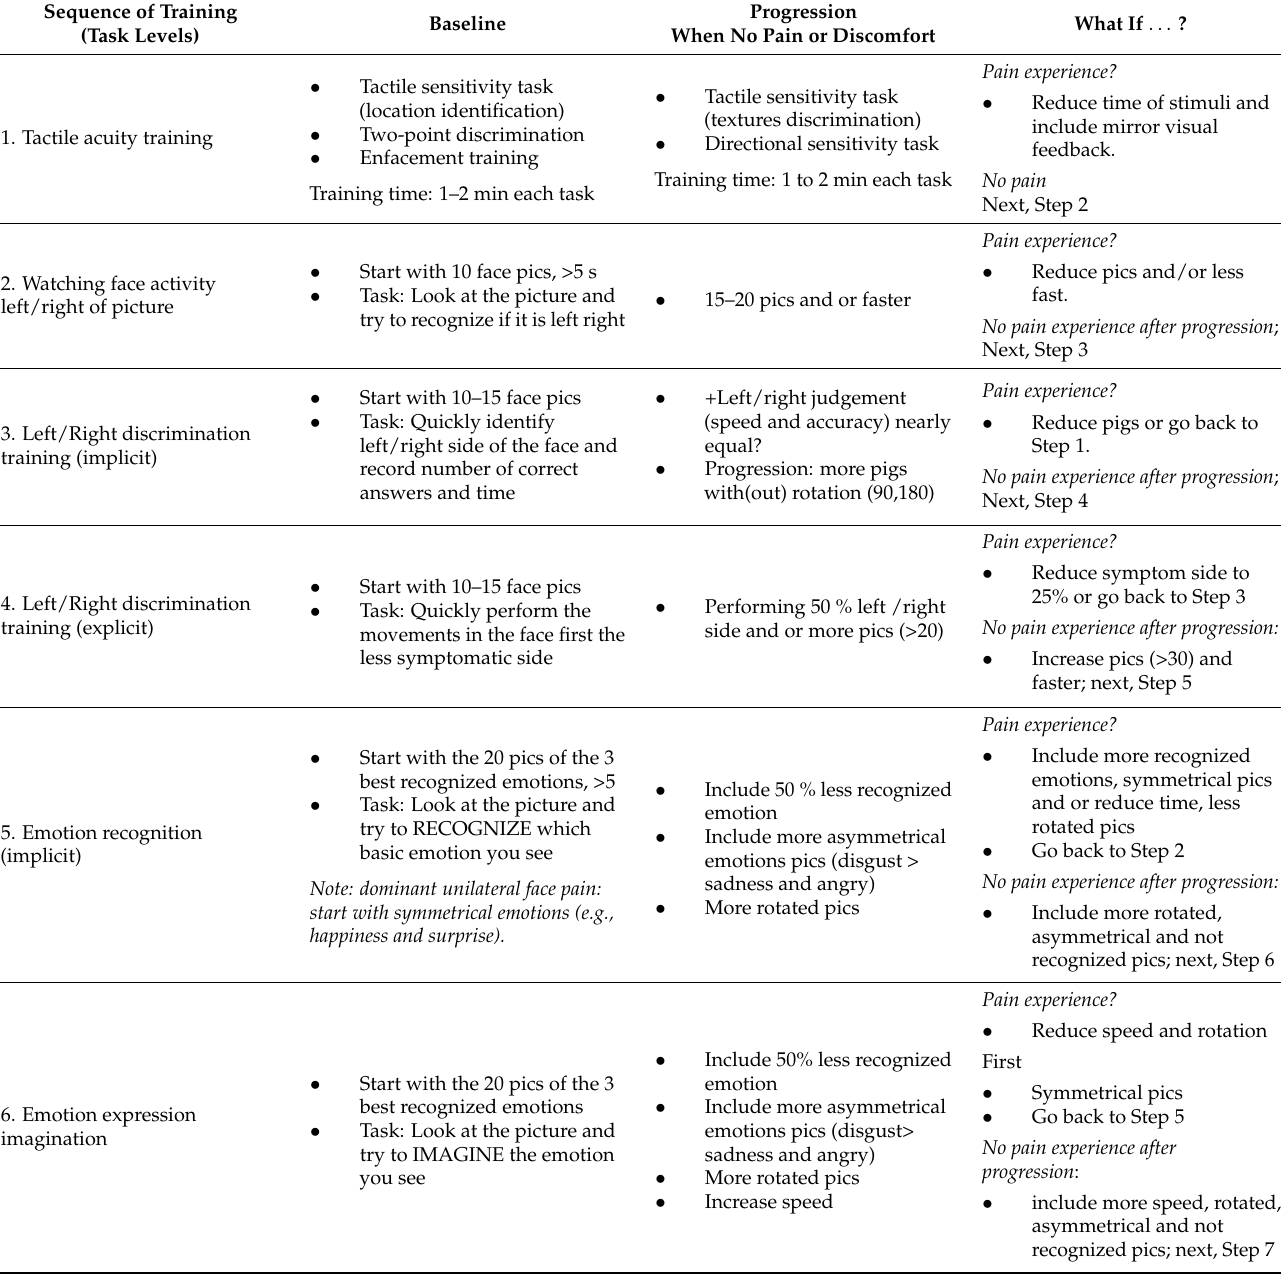
Table 1. Overview of a possible face training focused on distortion of orofacial somatorepresentation . Sequence of Training (Task